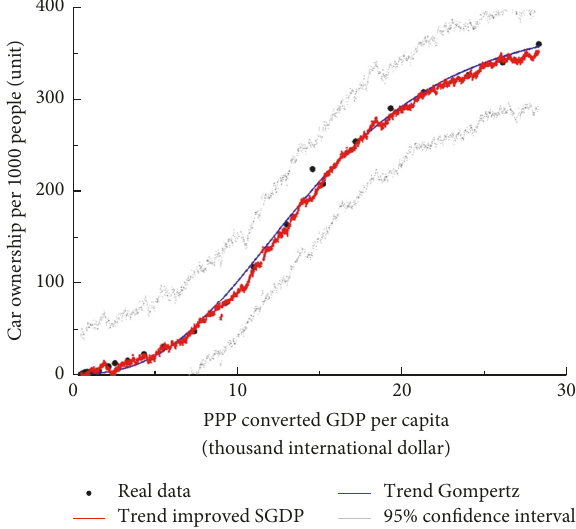
Figure 4: Real data versus Improved SDE Gompertz versus Trend Gompertz in the United Kingdom.